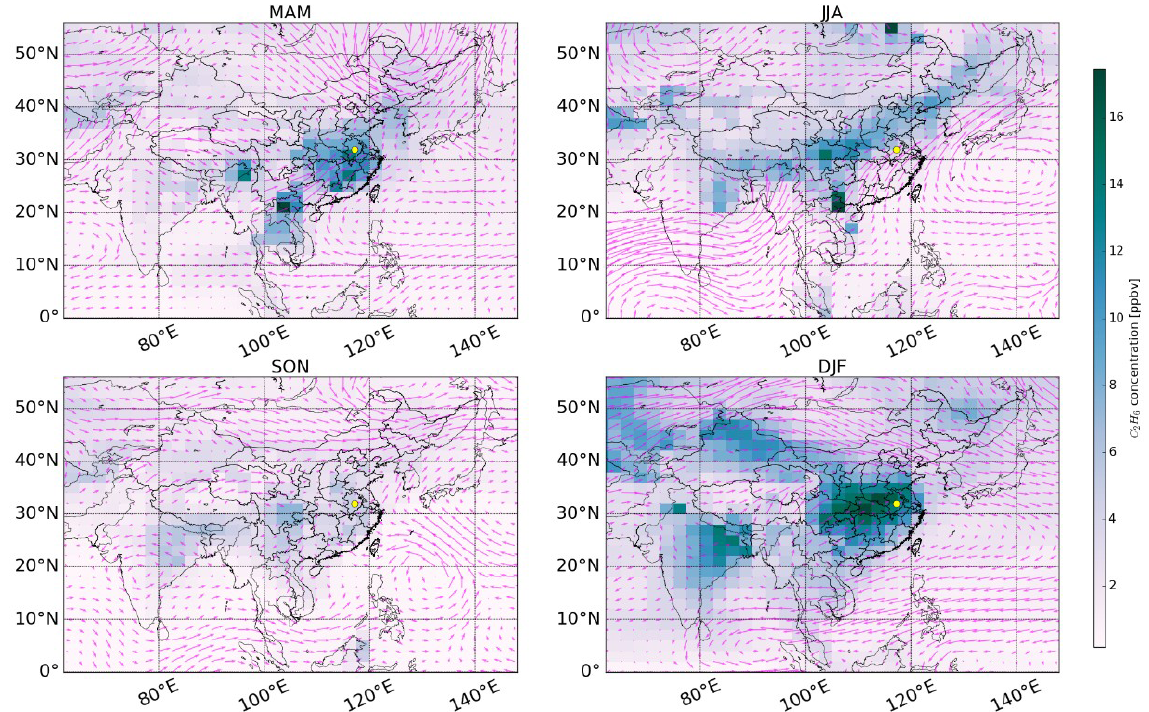
Figure 8. Spatial distribution of C 2 H 6 troDMF in the GEOS-Chem BASE simulations in different seasons. The arrows indicate horizontal wind vectors at 900hPa; the observation site is marked with a yellow dot. Meteorological fields are from the GEOS-FP 0.25 ◦ × 0.3125 ◦